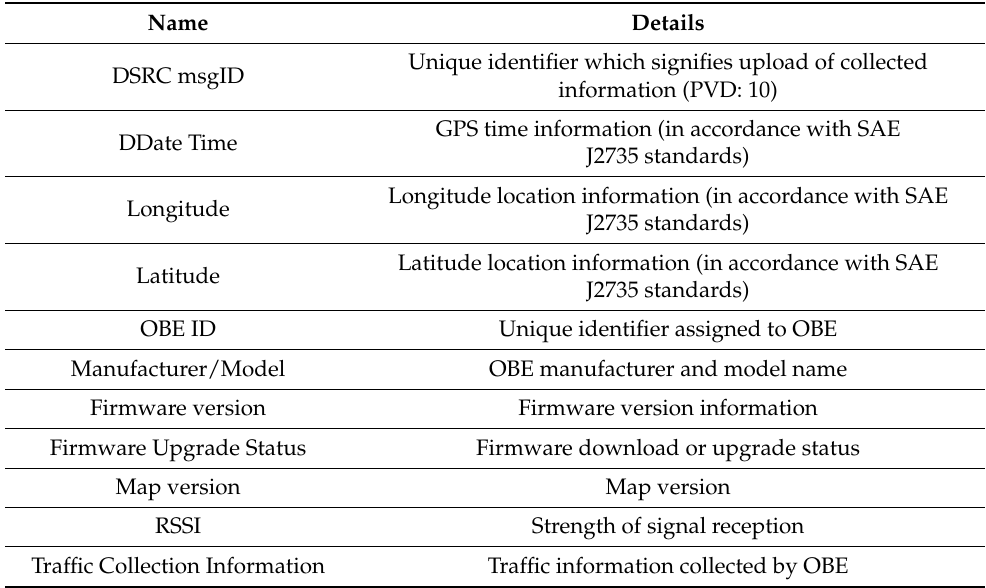
Table 2. Probe Vehicle